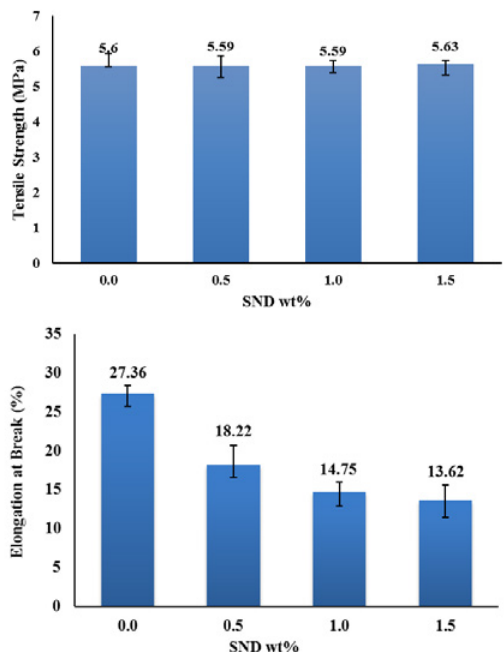
Fig. 5. Mechanical properties of pure and nanocomposite PSf membranes; tensile strength (top) and elongation at break (bottom)